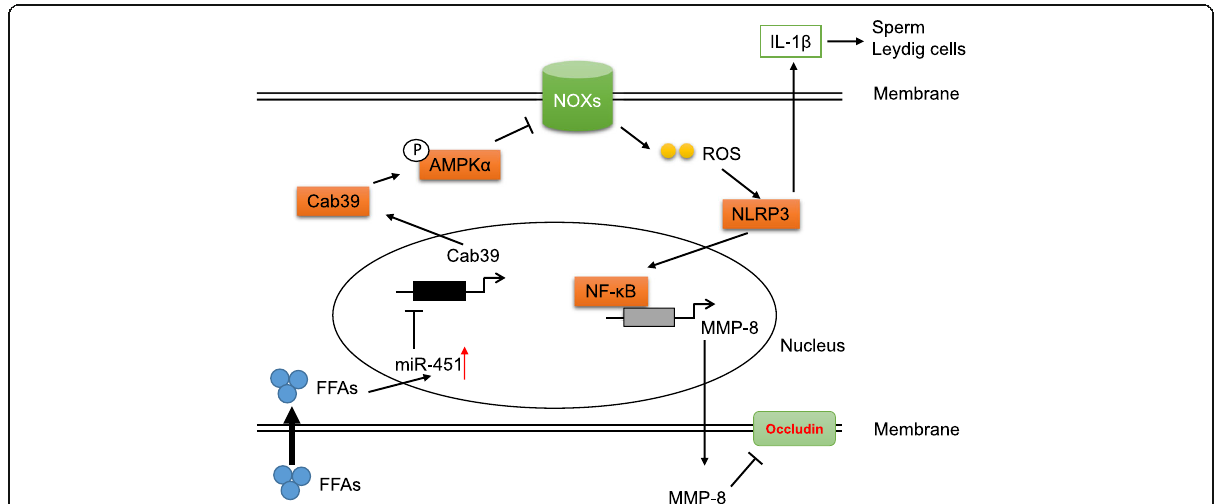
Fig. 9 The proposed mechanism of NLRP3 in obesity-induced subfertility. Free fatty acids (FFAs) induce miR-451 expression, which impairing AMPK α activity via targeting Cab39 and thus result in NADPH oxidases-dependent ROS production. NLRP3 activation caused by excessive ROS promotes IL-1 β secretion from SCs to impair testosterone synthesis and sperm performance, activates NF- κ B and increases MMP-8 expression to degrade occludin, thus affecting the BTB and